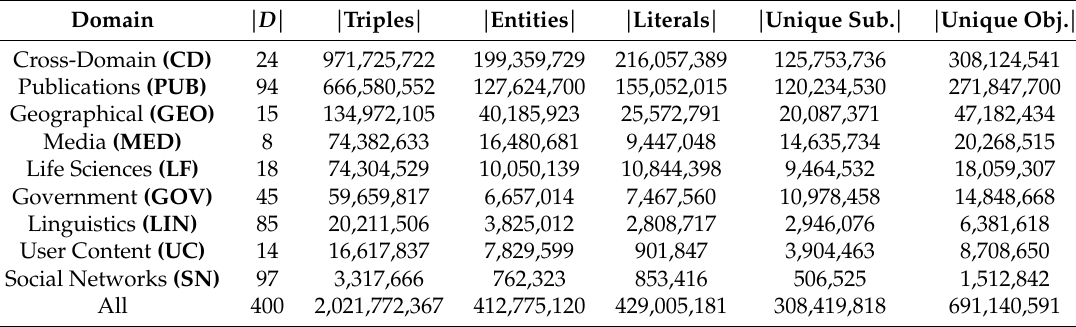
Table 4. Metadata of datasets which are used in the